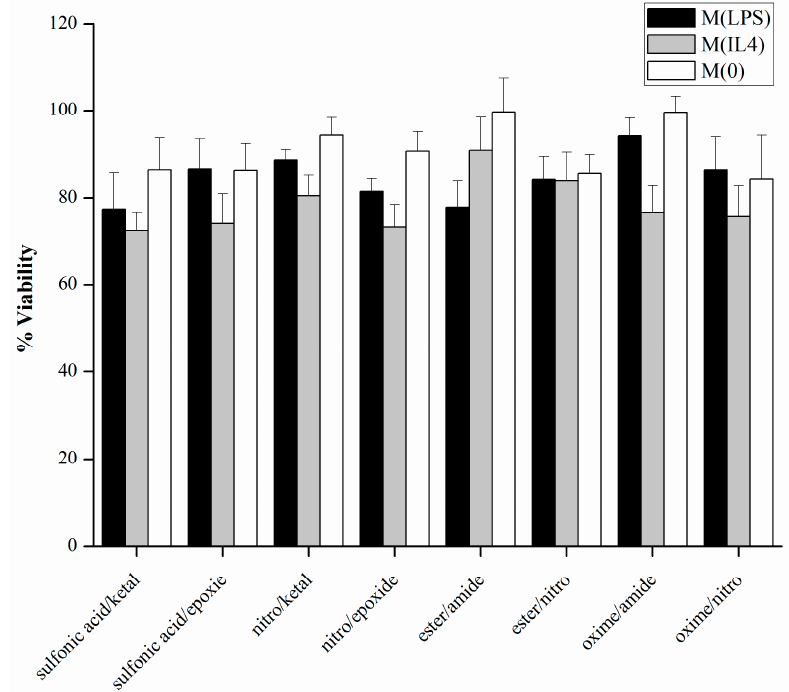
Figure 3. Modified alginates are cytocompaible. Cell viability of M(LPS), M(IL-4) and M(0) RAW 264.7 macrophages encapsulated under modified and unmodified alginate layers. n = 4. Data represent the mean value ± standard deviation.